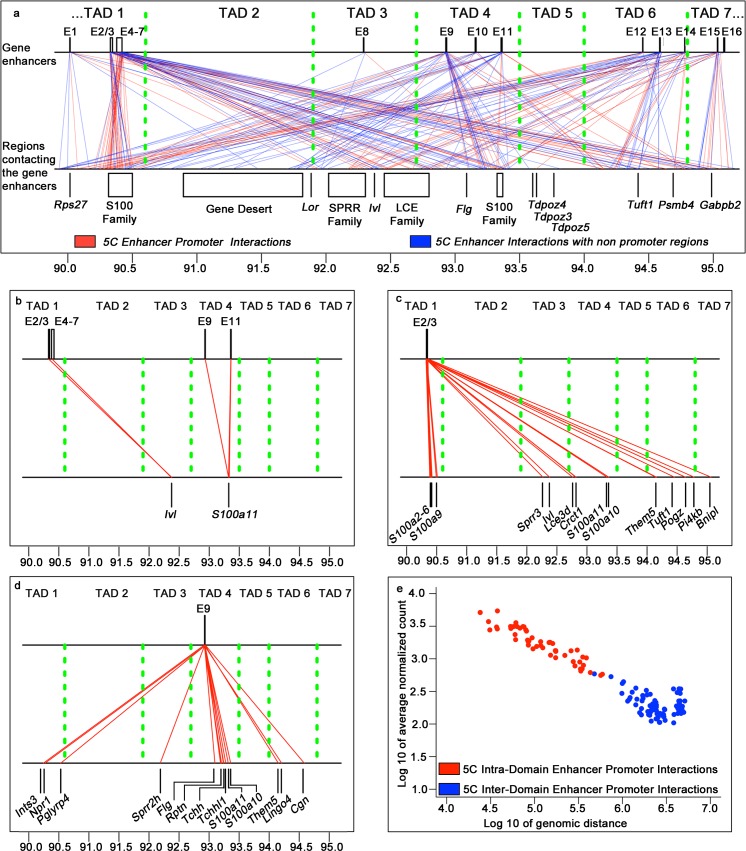
Spatial interaction networks between gene enhancers and promoters at the EDC locus in keratinocytes.(a) 5C looping interactions between gene enhancers (top line) and promoters (bottom line) (in red) and gene enhancers with regions not containing gene promoters (bottom line) (in bleu), TAD border midpoints are indicated by the vertical green lines. Schematic organization of the EDC locus is also shown. (b) 5C looping interactions involving Ivl and S100a11 gene promoters (bottom line) with their enhancers (top line), TAD border midpoints are indicated by the vertical green lines. (c) 5C looping interactions between the enhancer cluster E2/E3 (top line) and its putative target gene promoters (bottom line), TAD border midpoints are indicated by the vertical green lines. (d) 5C looping interactions between the enhancer E9 (top line) and its putative target gene promoters. (e) Scaling plot showing the normalized average counts versus genomic distances for the 5C looping interaction between gene promoters and enhancers within the TADs (red), and between the TADs (blue).